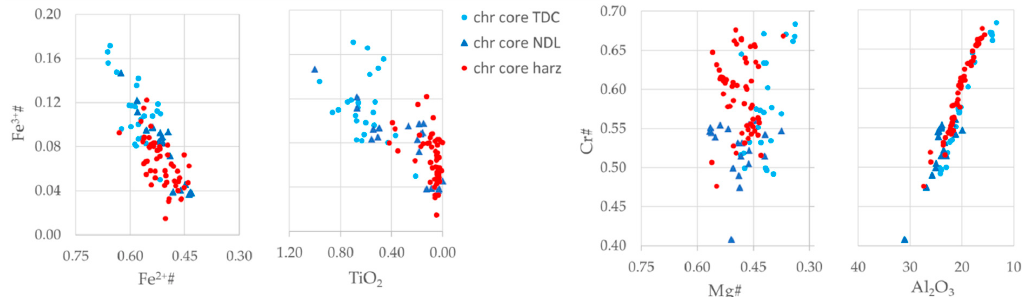
Figure 4. D iagram Fe 2 + # vs Fe 3 + #, TiO 2 wt. % vs Fe 3 + #, Mg# vs Cr# and Al 2 O 3 wt. % vs Cr# on Cr-spinel-core for TDC, NDL and harzburgite.